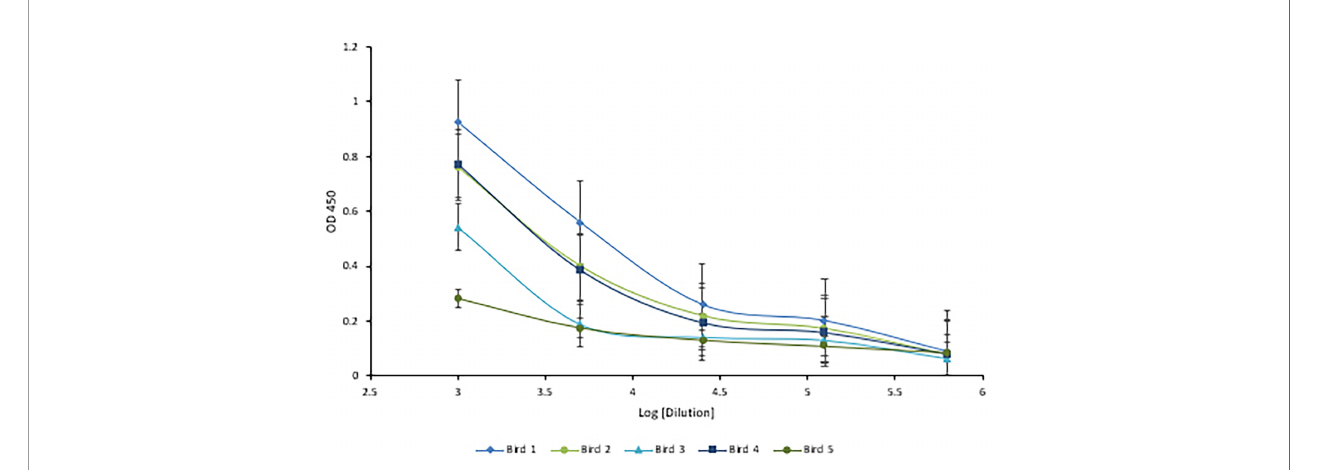
FIGURE 7 | Five-fold serial titration of anti-HRV titers after three immunizations. Titration of hyperimmune anti-HRV serum using a 5-fold serial dilution. An ELISA plate was coated with 10µg/ml of puri fi ed HRV and blocked with 2% BSA in PBS. Serum and yolk antibodies were serially diluted fi ve-fold in PBS containing 2% BSA. HRP-conjugated goat anti-chicken IgY served as the secondary antibody (1:3,000). A dilution of 125,000 (log [5.09]) was identi fi ed as the detection limit.